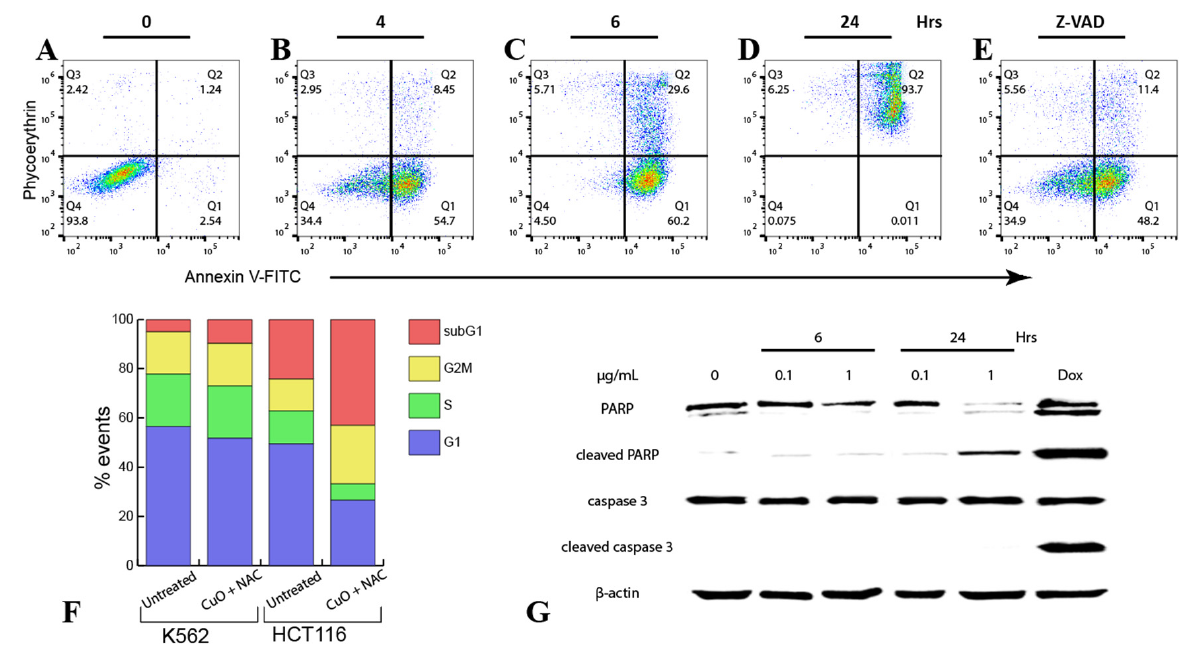
Figure 3. Death-associated events in cells treated with CuO NPs + NAC. The K562 ( A – G ) or HCT116 ( F ) cells were treated with 1 µg/mL CuO and 1 mM NAC for up to 24 h in the absence ( A – D , F ) or presence ( E ) of the pan-caspase inhibitor z-VAD (50 µ M, 4h), then washed and stained with annexin V-FITC/PI ( A – E ) or lysed in the PI/cell cycle buffer ( F ) followed by flow cytometry. ( G ) Immunoblotting with K562 cells. See the Materials and Methods (Section 4) and text for